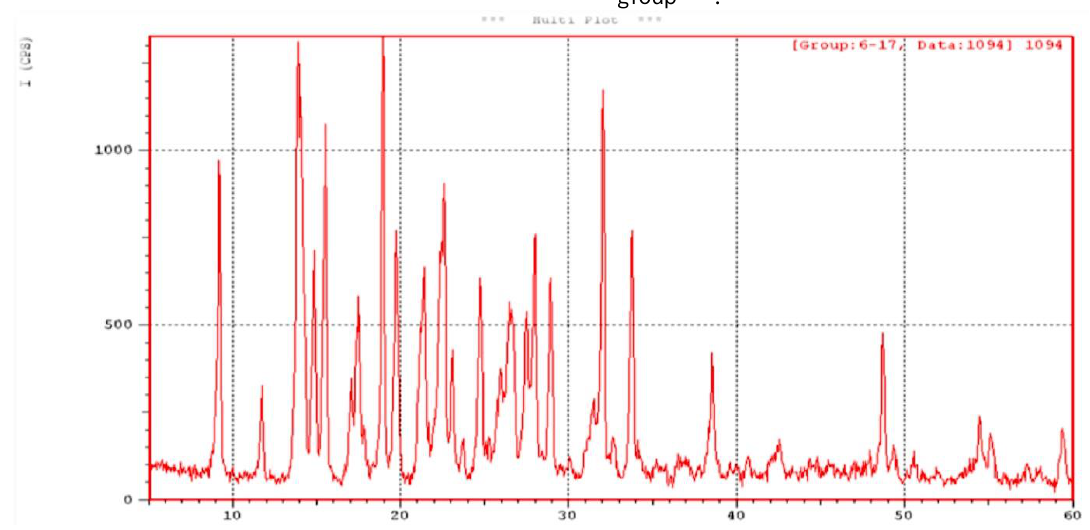
Figure 8. XRPD spectrum of pure